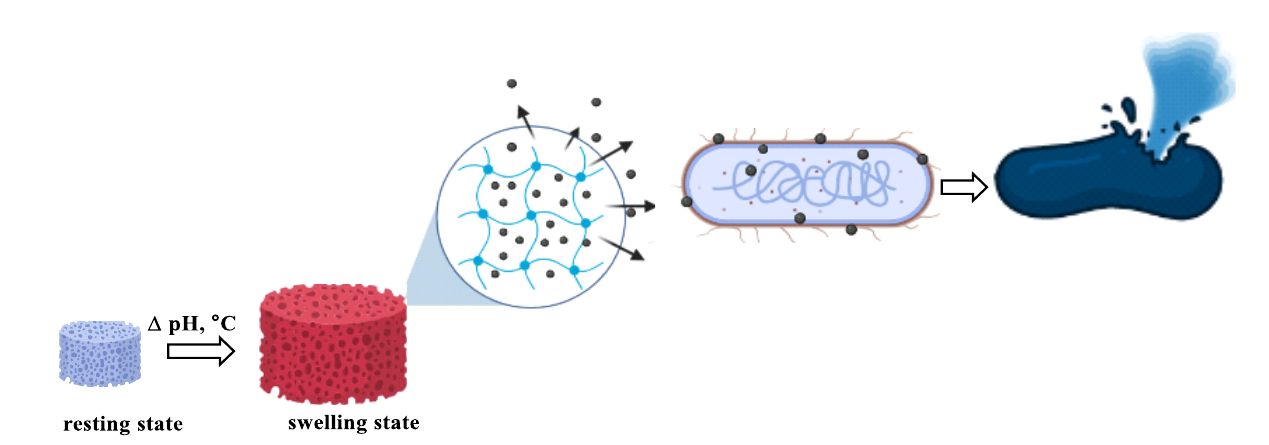
Figure 16. Growing of bacteria in the presence of CMCs-HEC (negative control).